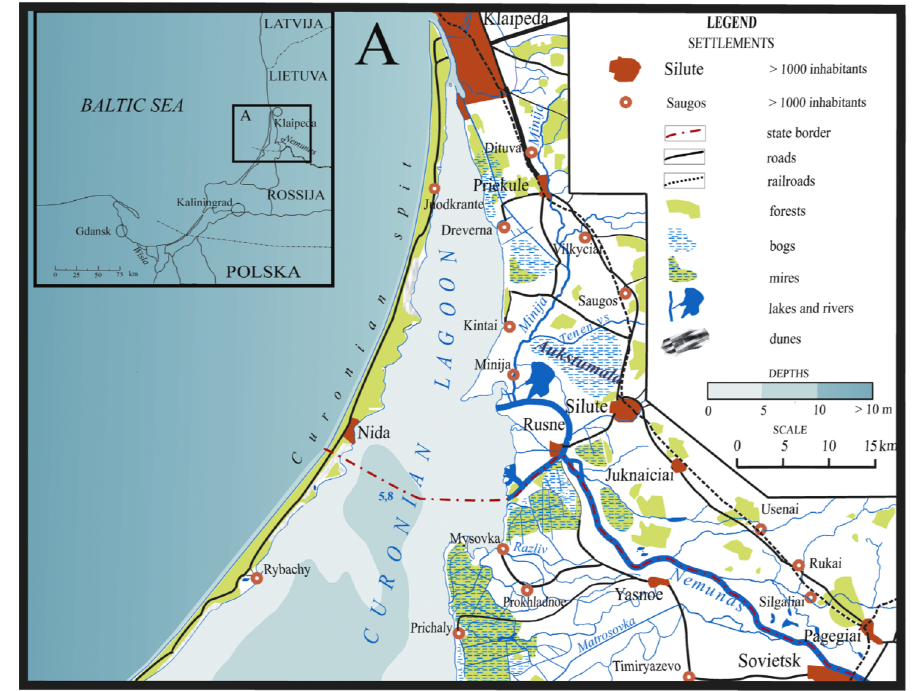
Figure 4. Curonian Lagoon (Lithuanian part). Source: authors’ own plotting.